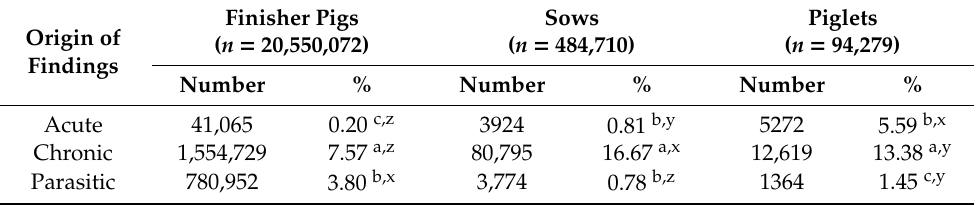
Table 4. Comparison of the number of individual patho-anatomic findings in liver in finisher pigs, sows and piglets slaughtered in the